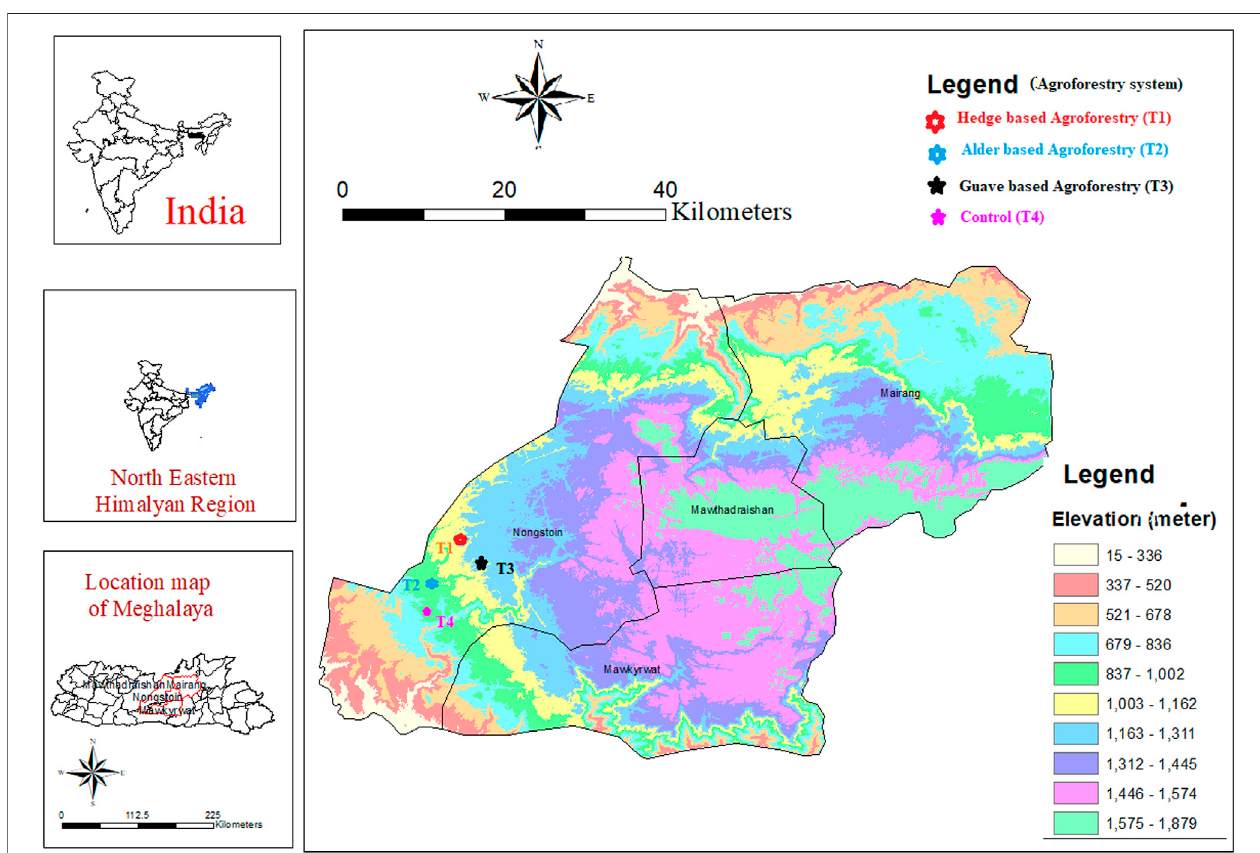
FIGURE 2 | Location map of the study area in Meghalaya of